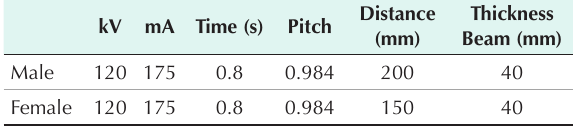
Table 1. Exposure Parameters in the Cervical Protocol